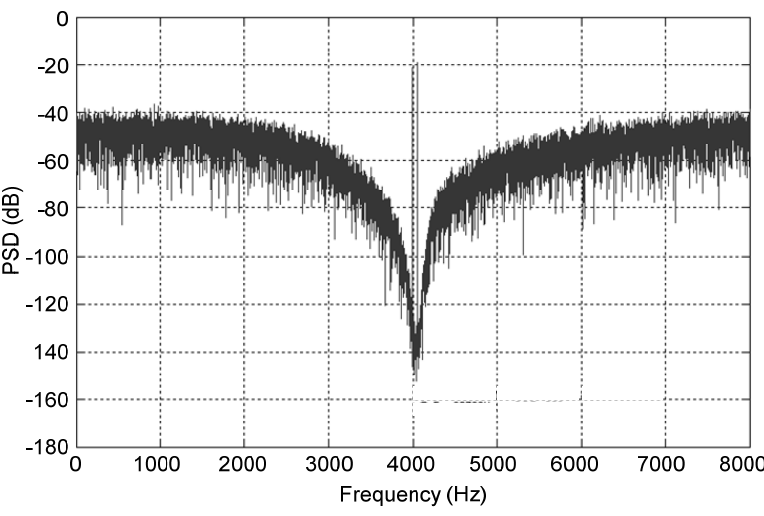
Figure 8. Power spectral density of the final gyroscope